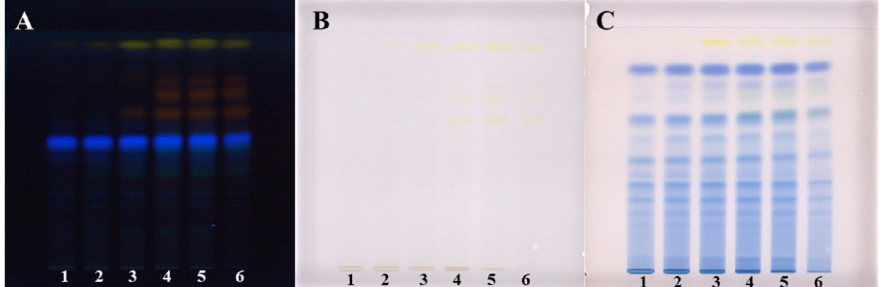
Figure 2. HPTLC chromatograms of Japanese knotweed rhizomes STSs (2 μ L, 50 mg/mL) prepared with water (track 1), 20% ethanol (aq) (track 2), 40% ethanol (aq) (track 3), 60% ethanol (aq) (track 4), 80% ethanol (aq) (track 5) and ethanol (track 6). HPTLC silica gel plates were developed with toluene– acetone–formic acid (3:6:1, v / v ). Images of the plates were documented at 366 nm ( A ) and at white